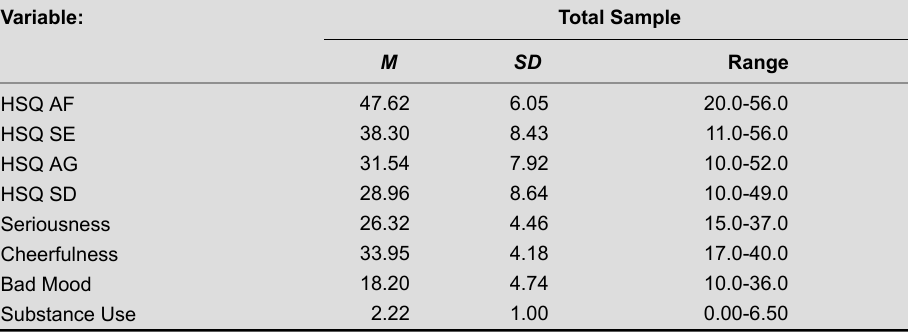
Note: HSQ AF = Affiliative Humor, HSQ SE = Self-enhancing Humor, HSQ AG = Aggressive Humor, HSQ SD = Self-defeating